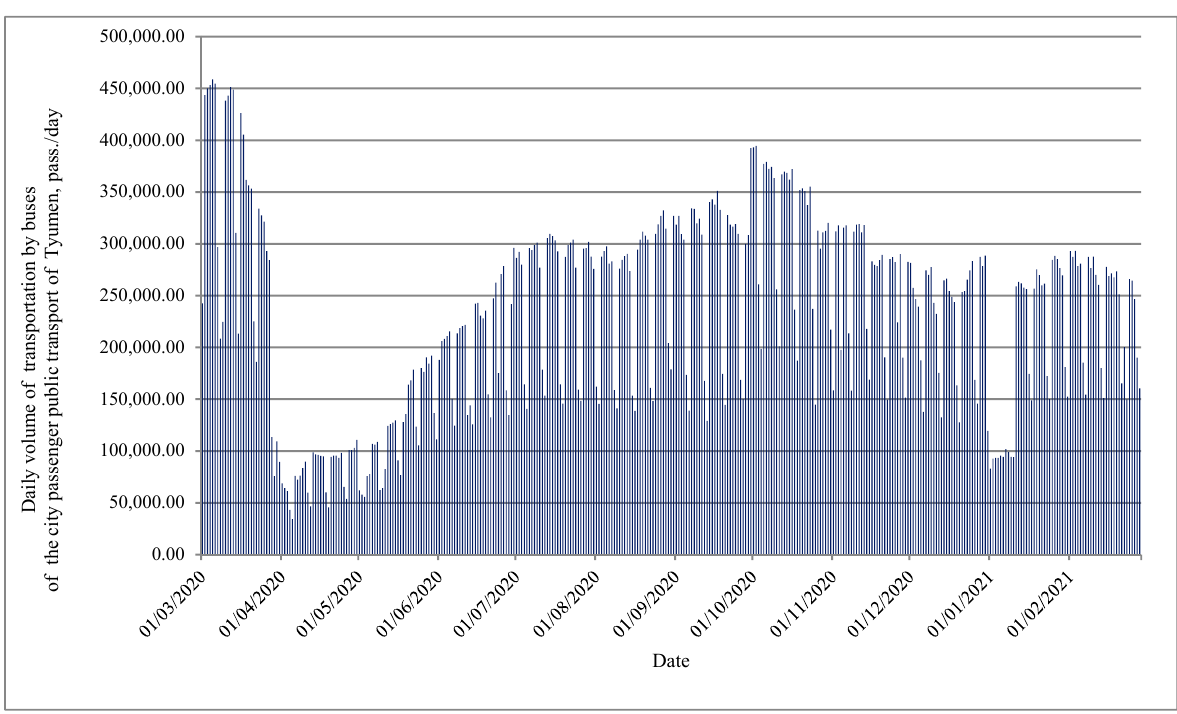
Figure 7. The change in daily transportation volume of Tyumen CPPT during March 2020–February 2021. Notes: 1. The sharp decrease of daily transportation volume in the period of 31 December 2020 to 10 January 2021 is explained by long new-year holidays (non-working days for a population of the Russian Federation).2. The periodical decrease of Q daily is explained by a sharp decrease in transportation volume on weekends and increase on